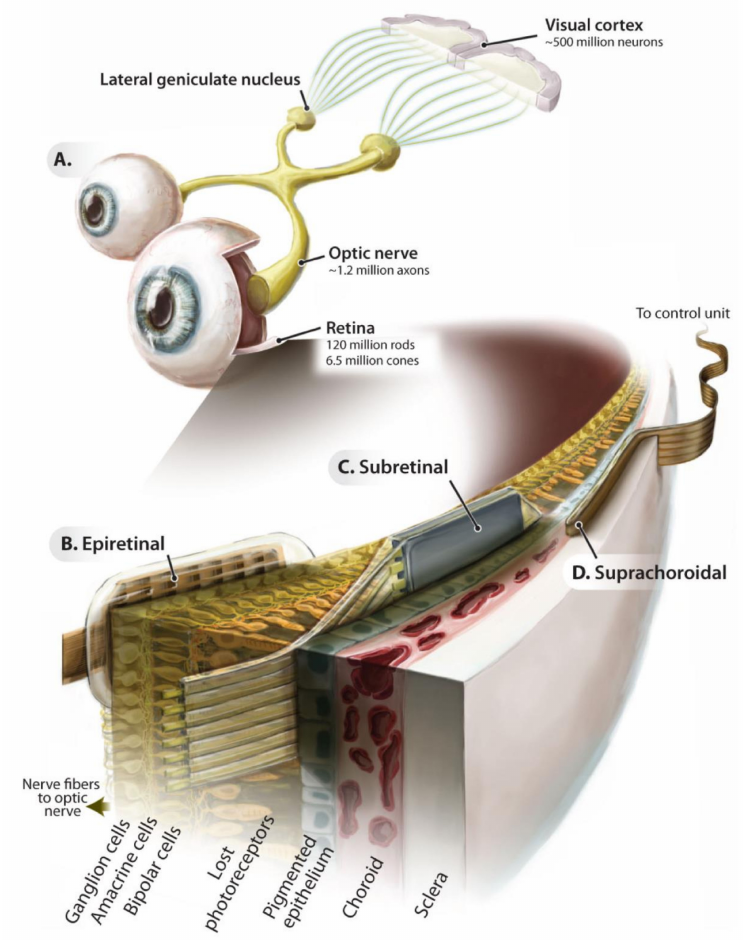
Figure 2. Introduction to retinal electronic prostheses. Schematic of the ascending visual pathway ( A ) and implantation locations of the epiretinal ( B ), subretinal ( C ), and suprachoroidal ( D ) implant prostheses. Adapted with permission from Eberhart Zrenner